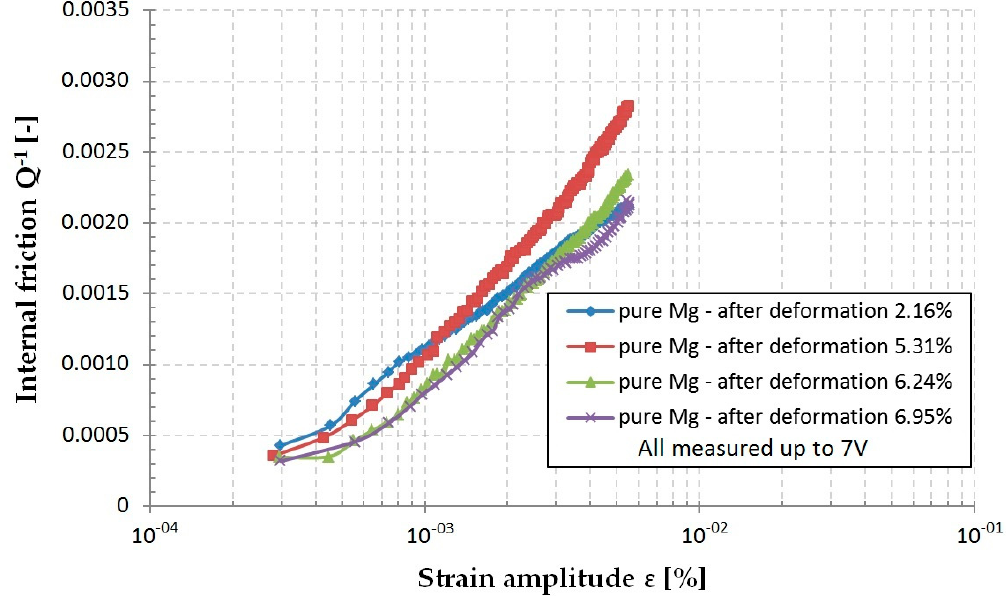
Figure 21. ADIF measured in the predeformed magnesium samples.